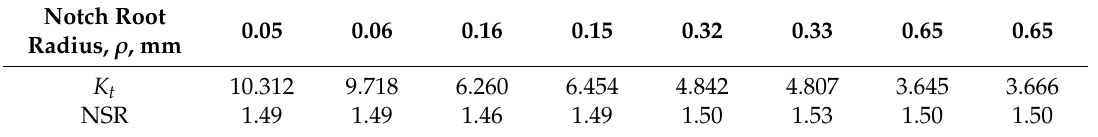
Table 2. Stress concentration factor and notch strength ratio of as-built material. Notch Root